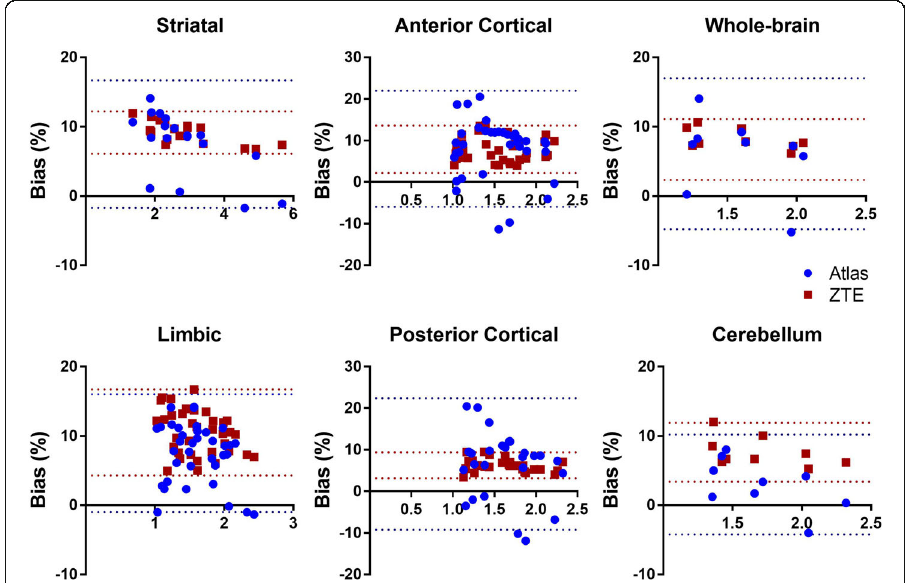
Fig. 7 SUV bias plots of ZTE-AC and atlas-AC compared to 68 Ge-AC for different brain regions. Dashed lines represent confidence intervals associated to ZTE-AC and